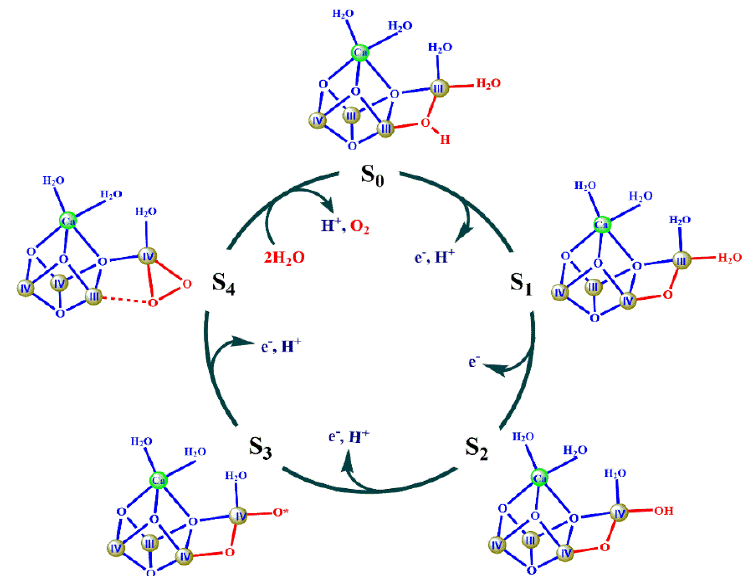
Figure 4. The second proposal for the O-O bond formation involving the µ 2 -oxide bridge (O4) and one water molecule (W1) on the dangler Mn [79]. All other depictions are the same as that in Figure 3. For clarity, all protein ligands of the OEC are omitted. The proton released during the S 3 → S 4 state transition is from D 1 -Asp 61 instead of the binding water molecule.